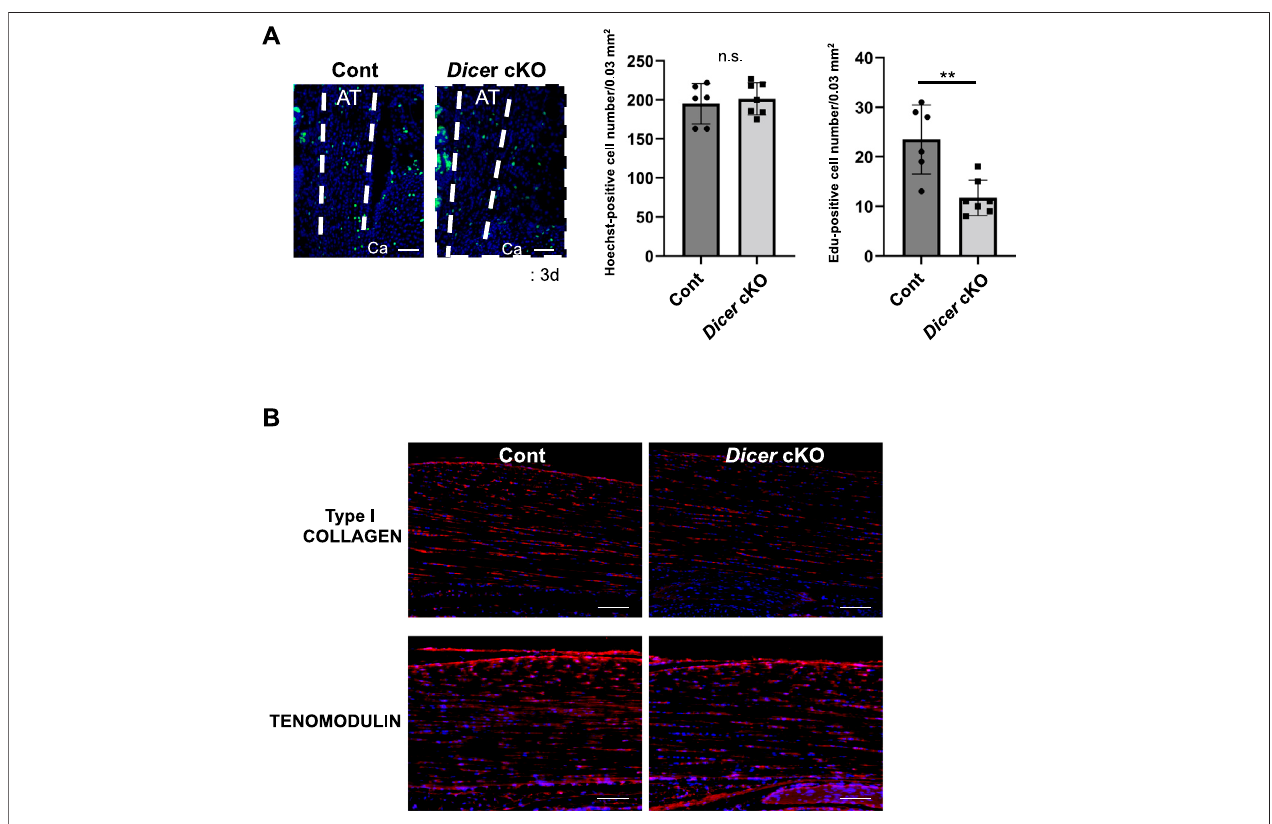
FIGURE5| CellularityinAchillestendonsof Dicer cKOmice. (A) Edu-positivecellsweredecreasedinAchillestendonsof Dicer cKOmiceatpostnatalday3( n =6 – 7 mice for each genotype). Scale bars: 50 µm. (B) Immunohistochemistry using anti-TENOMODULIN antibodies and anti-PRO COLLAGEN TYPE I antibodies of Achilles tendonsofContand Dicer cKOmice at3 weeksofage( n =5per group).Data are represented as mean ± S.D. Comparison of mean values was performed using (A) Welch ’ s t testand (B) two-wayANOVA;* p < 0.05, ** p < 0.01versusCont. AT: Achillestendon.Ca:calcaneus.Scalebars:100 μ m.n.s.: nosigni fi cantdifference.